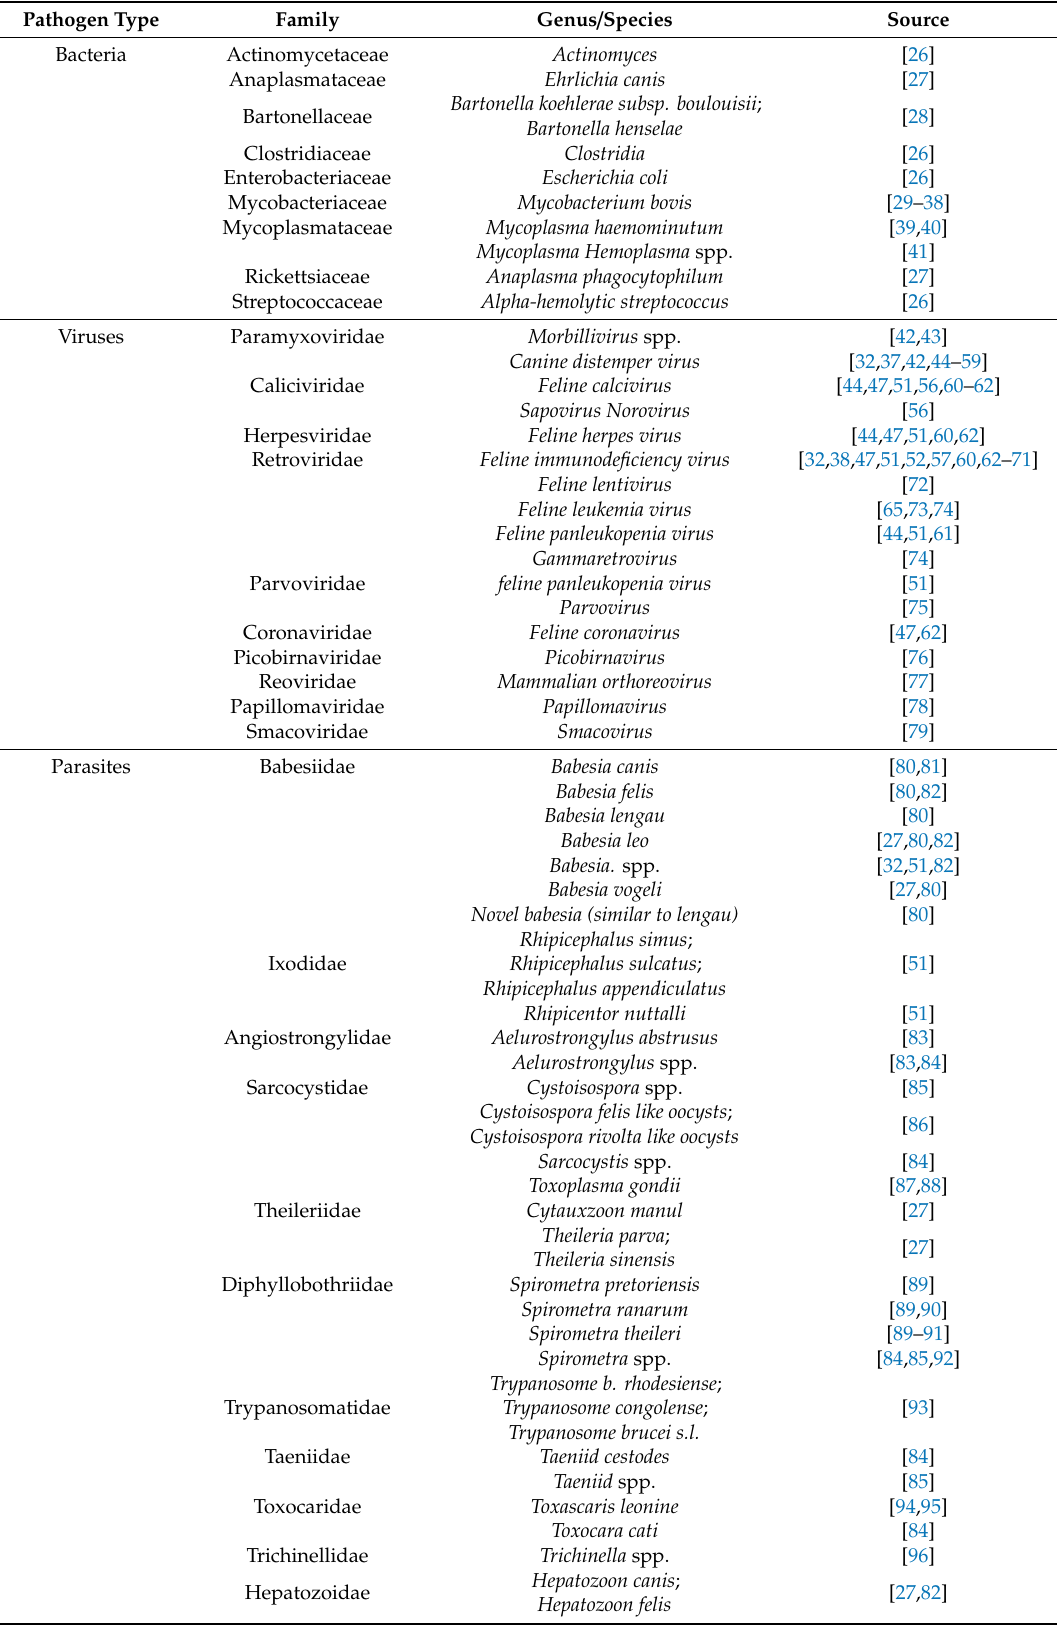
Table 1. Pathogenic organisms (categorized into bacteria, parasites, and viruses) specified in the 148 papers in the